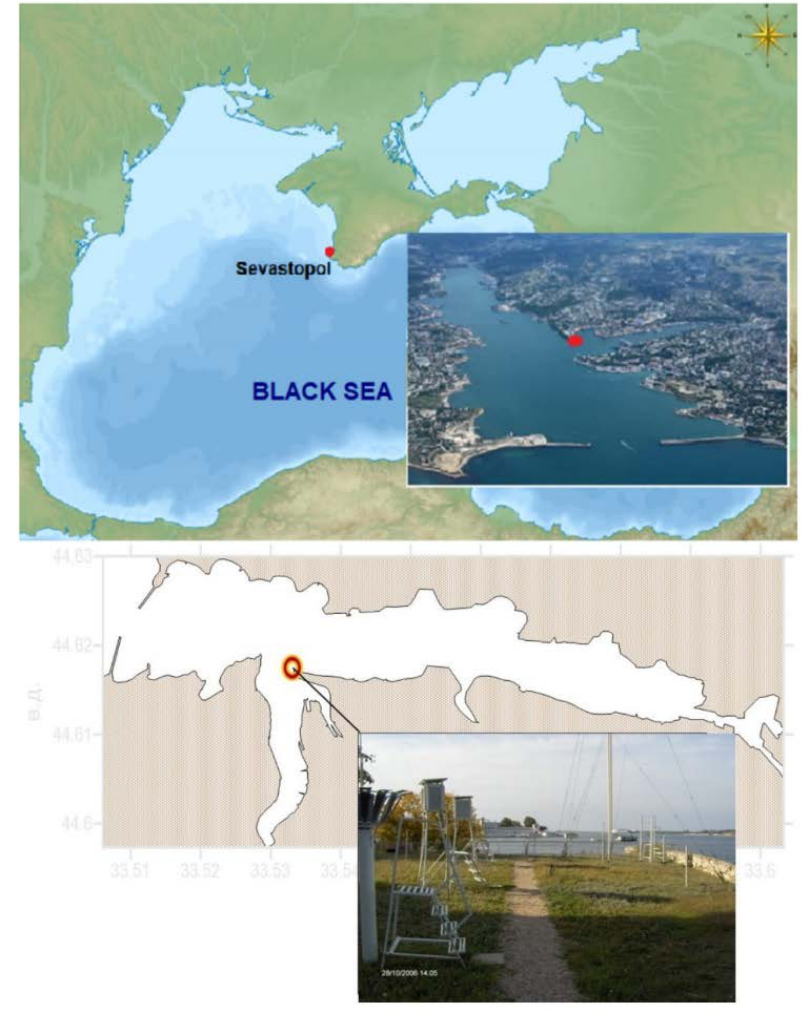
Figure 1. Sampling